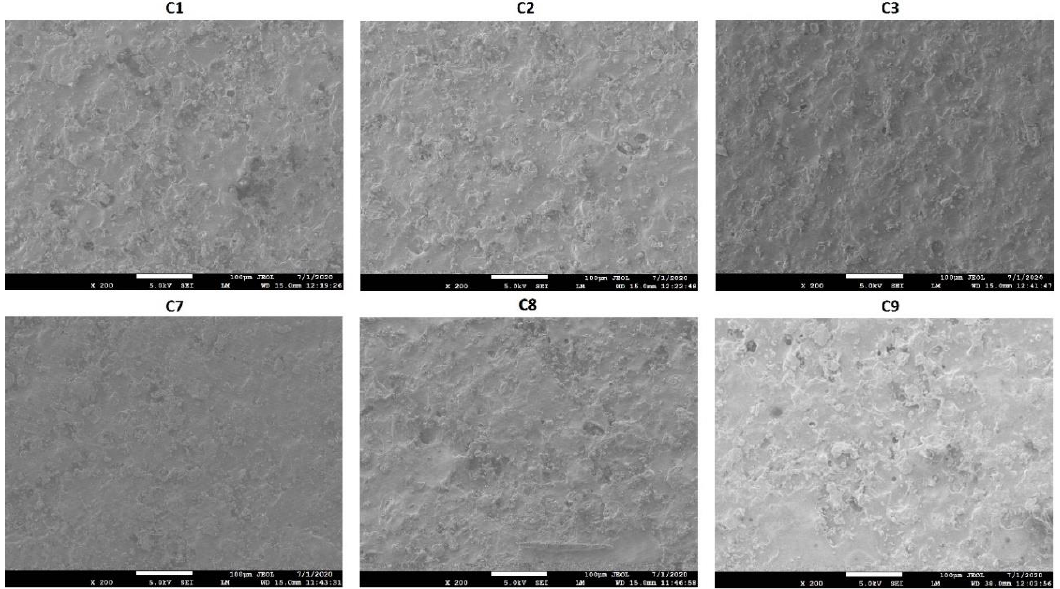
Figure 1. Surface morphology of tablets coated with blends of cellulose acetate butyrate (CAB) 171-15/C-A-P.